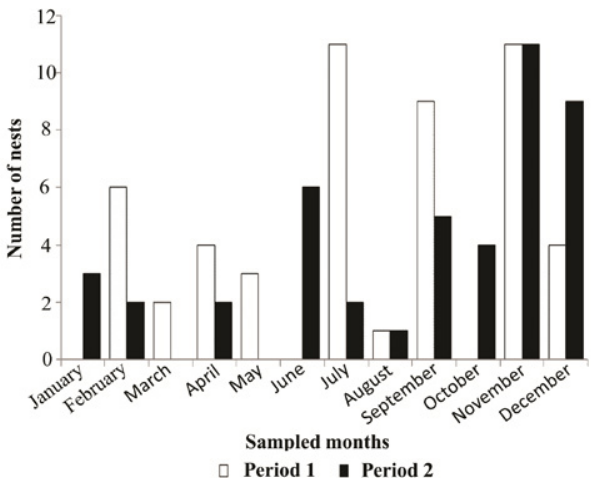
Fig 2. A bundance of Tetrapedia curvitarsis nests obtained in Period 1 (April 2009 to March 2010) and in Period 2 (April 2012 to March 2013), at the Água Limpa Experimental Station, Uberlândia-MG.